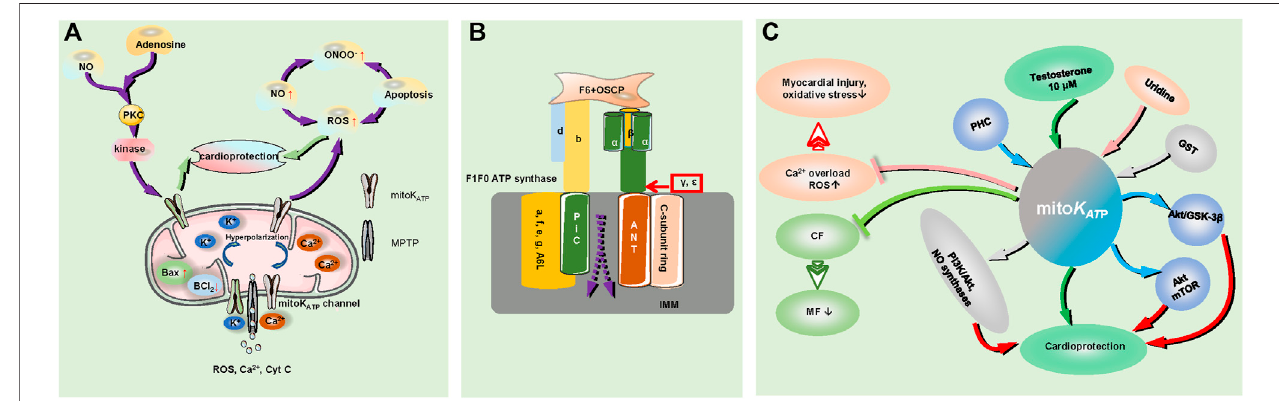
FIGURE 2 | The role of mitoK ATP in myocardial ischemia and the regulation of the signaling pathways involved. (A) . Mitochondrial injury and mitoK ATP play a role in cardiac protectionduringtheprocess ofMIRI; MIRIincreasedBaxexpression and decreasedBCL 2 expression, triggeringacascadeinvolvingincreasedNOproduction and leading to the super fi cial formation of ONOO − with increased production of ROS. Activation of mitoK ATP stimulates the anti-in fl ammatory and antioxidant effects of NOonischemicmyocardiumbyinhibitingtheoverproductionofROS.IschemicpostadaptationactivatesproteinkinaseCandthereperfusioninjurysalvagekinase pathway throughtheintracellularconcentrationofadenosineandNO,anditactsonthemitoK ATP channeltoprotectthemyocardium; activationofthemitoK ATP channel leadstocellhyperpolarization,resultinginreducedCa 2+ entry,andareduceddrivingforceofmitochondrialcalciumuptake,preventCa 2+ accumulationinthematrixand MPTP formation. The MPTP is the escape pore of ROS, Cyt C, Ca 2+ and other signaling molecules. CF indicates cardiac fi broblasts; MF, myo fi broblasts; MIRI, myocardialischaemiareperfusioninjury;andONOO − ,peroxynitrite. (B) .ThestructureofMPTP;F1FoATPsynthase:TheFosubunitconsistsofa,e,f,gandA6L,theF1 component consists of α and ß subunits, labeled in bottle green and yellow, respectively, and the γ , ε subunits. The F1 peripheral stalk iscomprised ofsubunits b, d,F6, and OSCP. The C cyclic subunit, ANT and PiC are overlaid by IMM; the dotted line represents the MPTP signal molecule out fl ow position. OSCP indicates oligomycin sensitivity conferring protein; IMM, inner mitochondrial membrane; ANT, adenine nucleotide translocase; and PiC, phosphate carrier. (C) . mitoK ATP channels prevent transdifferentiationofCFtoMFtoreduceMFmaturation.Testosterone(10 μ M)increasestheopeningprobabilityofmitoK ATP channels,PHCregulatesthemitochondrial K ATP channel, Akt/GSK-3 β , and Akt/mTOR signaling pathways, GST depends on protein-kinase C and mitoK ATP channel pathway activation by some typical pathways such as PI3K/Akt and NO synthases, and plays roles in cardioprotection. Uridine attenuates myocardial injury and oxidative stress by activating the mitoK ATP channel to reduce excessive ROS production and prevent calcium overload. PHC indicates penehyclidine hydrochloride; GST,